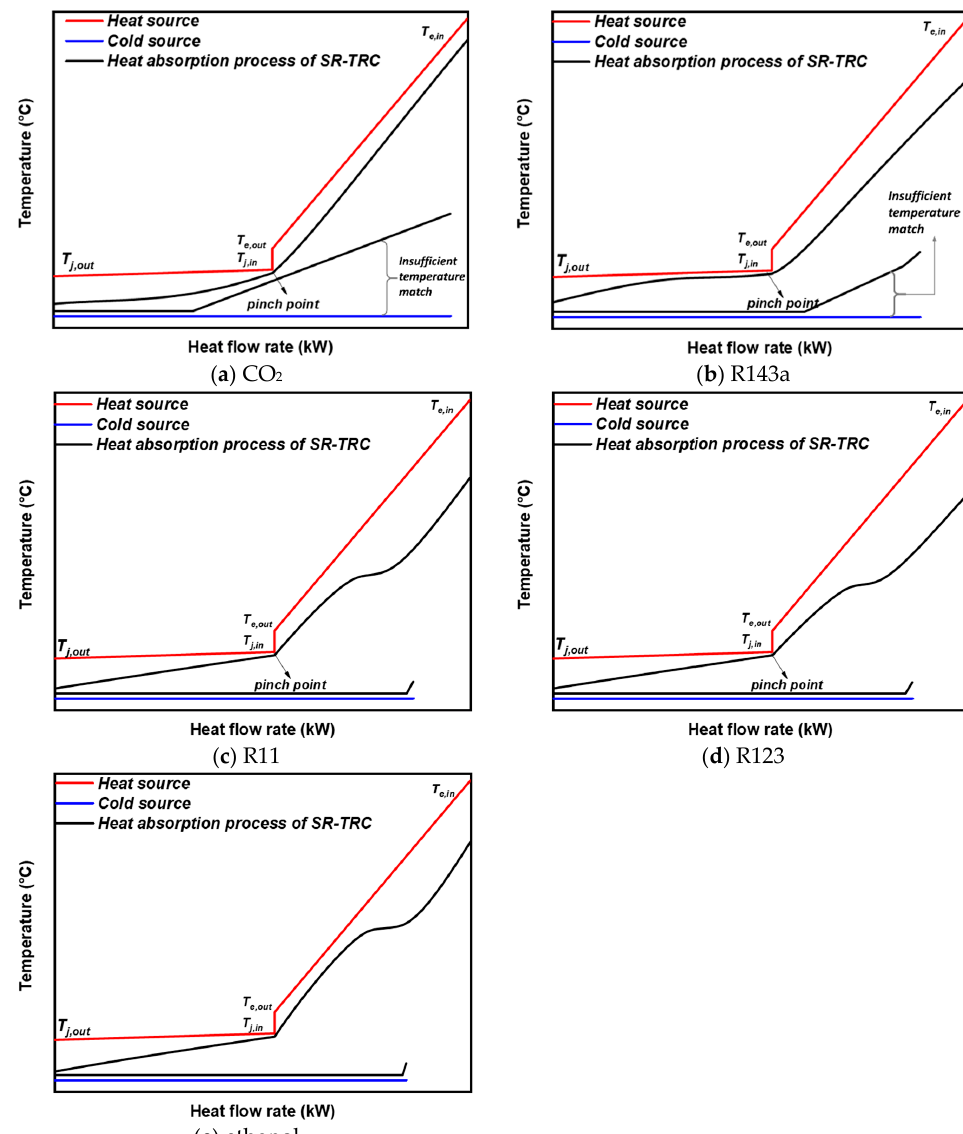
Figure 4. The temperature matching diagrams: ( a ) CO 2 , ( b ) R143a, ( c ) R123, ( d ) R11, and ( e ) ethanol.